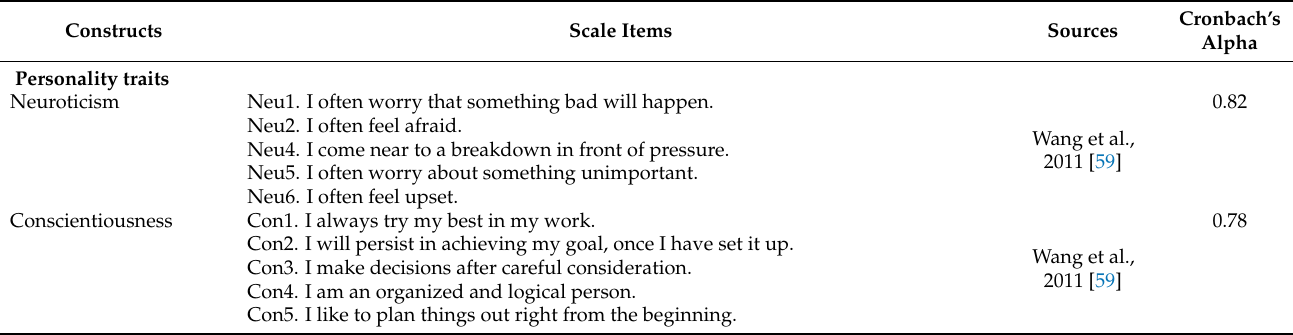
Table 1. Constructs items in the